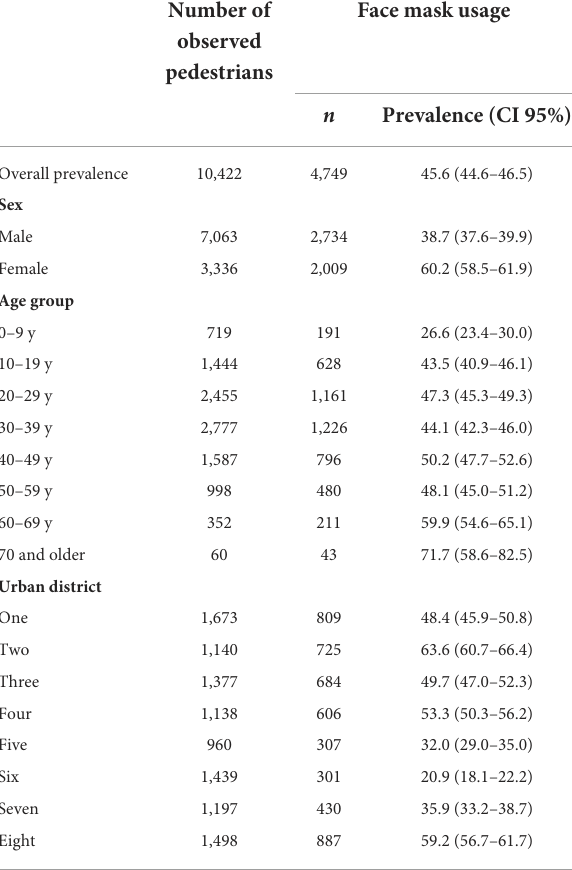
TABLE 1 Prevalence rates of face mask usage by sex, age group, and urban district (4).